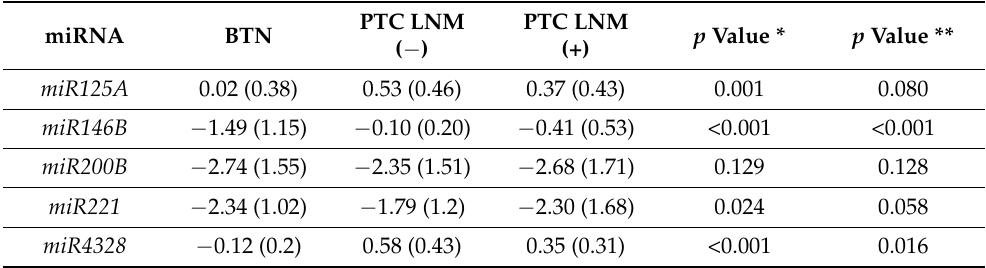
Table 6. Comparison of miRNA relative expression between the BTN, PTC without LNM and PTC with LNM groups; and between PTC with LNM and PTC without LNM groups. PTC LNM miRNA BTN